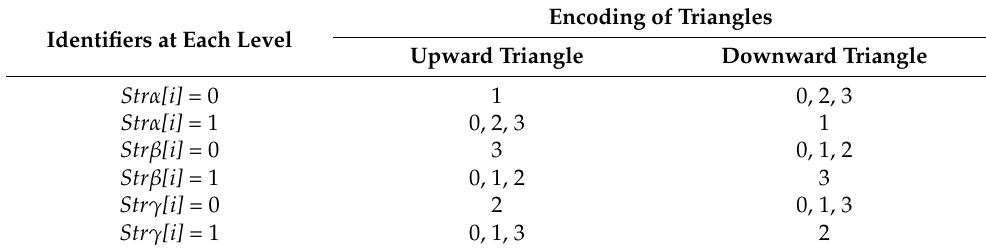
Table 4. Correspondence rules of three-orientation coordinates and encodings.